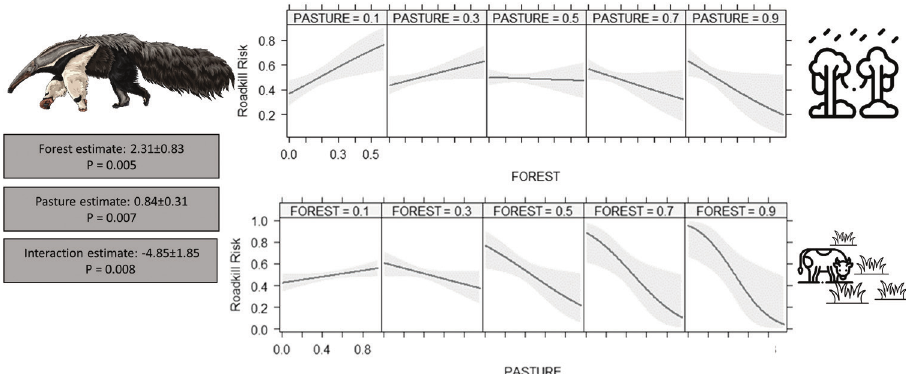
Figure 6. Best model selected by AIC for M. tridactyla and its estimated coefficients. The best model shows an interaction between forest and pasture, both variables positively related to roadkill risk, but the size and effect of direction changes according to the proportion of the other